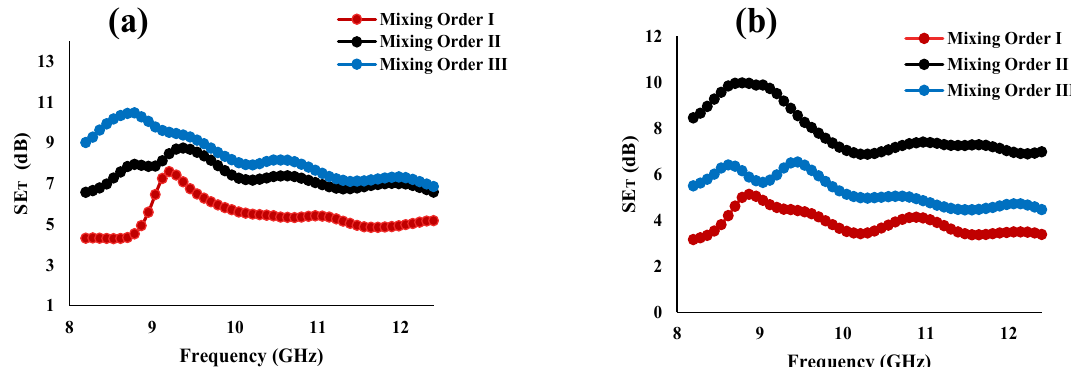
Figure 10. Total Shielding effectiveness (SE T ) of melt processed PS/aPA6 (25:75)/5 vol% MWCNT ( a ) at l voI% PSMA and ( b ) 3 vol% PSMA. MO-II has best performance for 1 vol% PSMA but MO-III is best for 3 vo1% PSMA. MO-I consistently has lowest SE T .